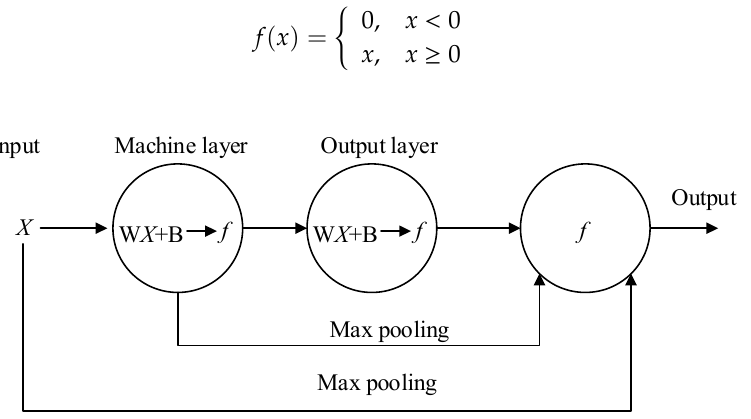
Figure 2. Architecture of the CNN.